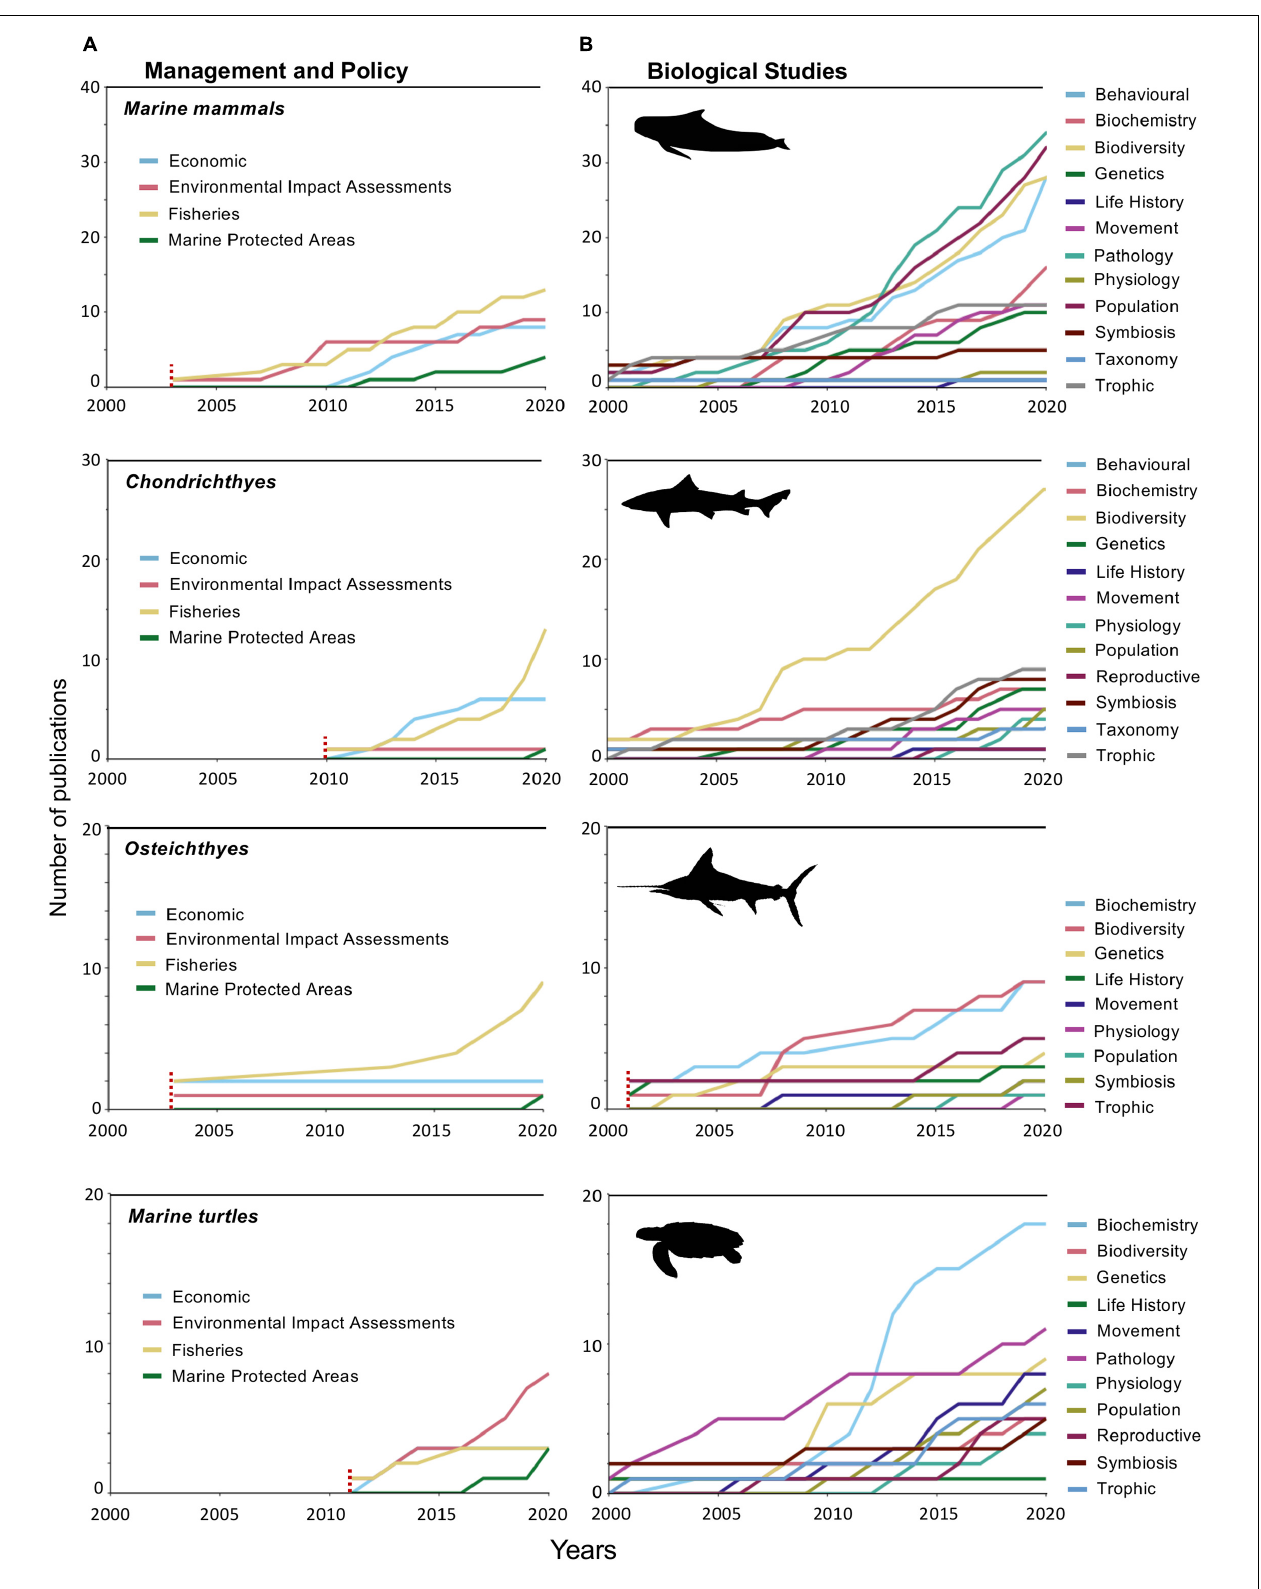
FIGURE 5 | Sub-topic evolution of (A) management and policy, and (B) biological studies per marine megafauna group, over the past two decades (2000–2020). Dashed red line indicates the first research article published within the respective topic. Note differences in scale per taxa.